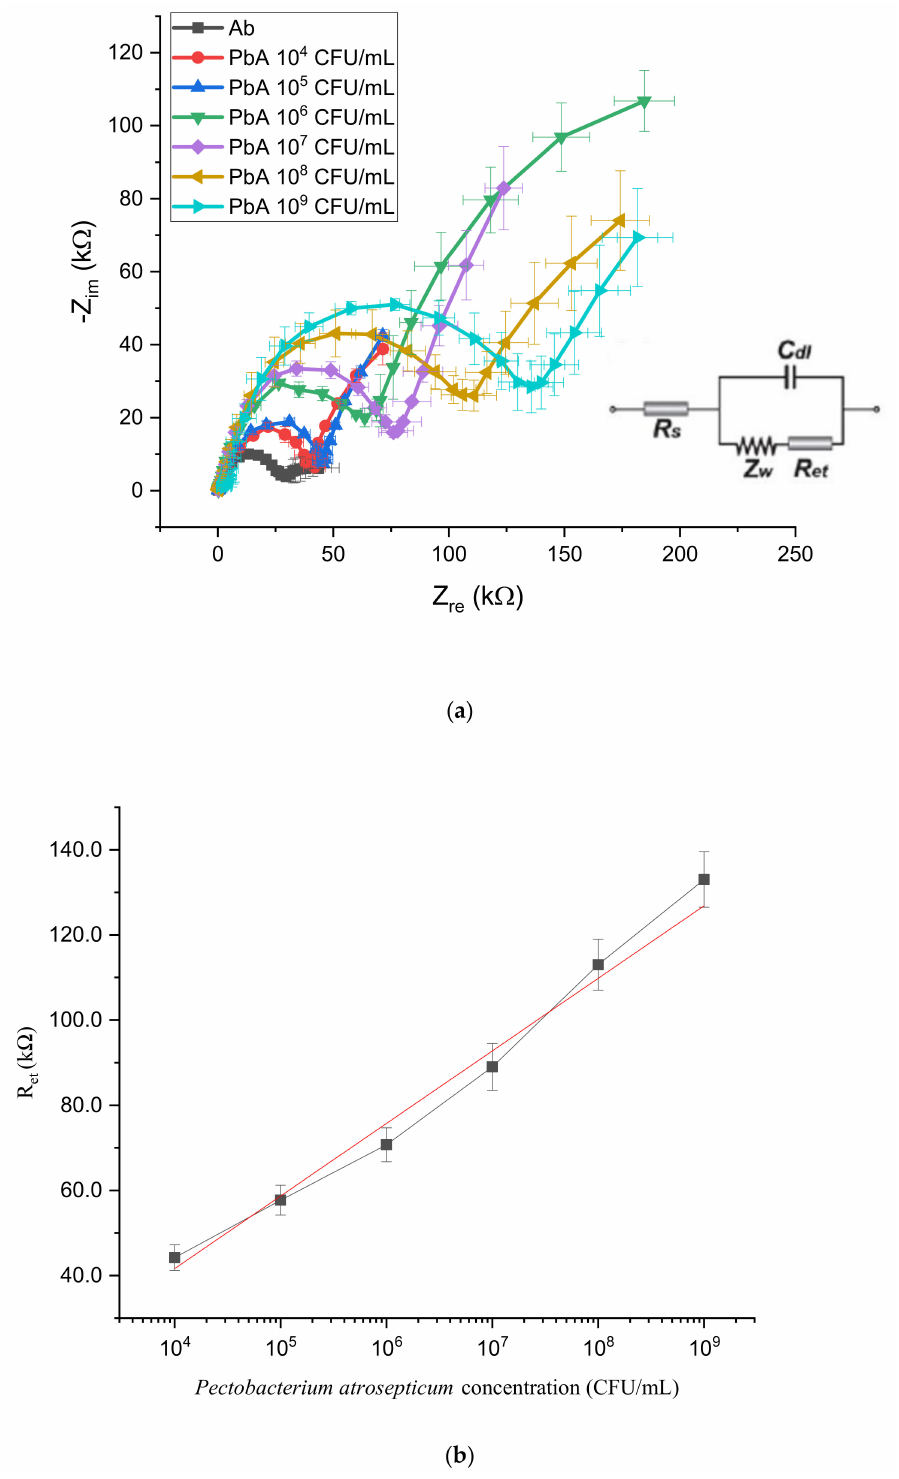
Figure 4. ( a ) Nyquist spectra obtained in lab-on-a-chip (LOC) device calibration. Curves from cyan to red correspond to di ff erent concentrations of Pectobacterium atrosepticum in spiked solutions; each curve is the average of three di ff erent measurements. ( b ) Impedance values as a function of Pectobacterium atrosepticum concentration: each point is the average of three di ff erent